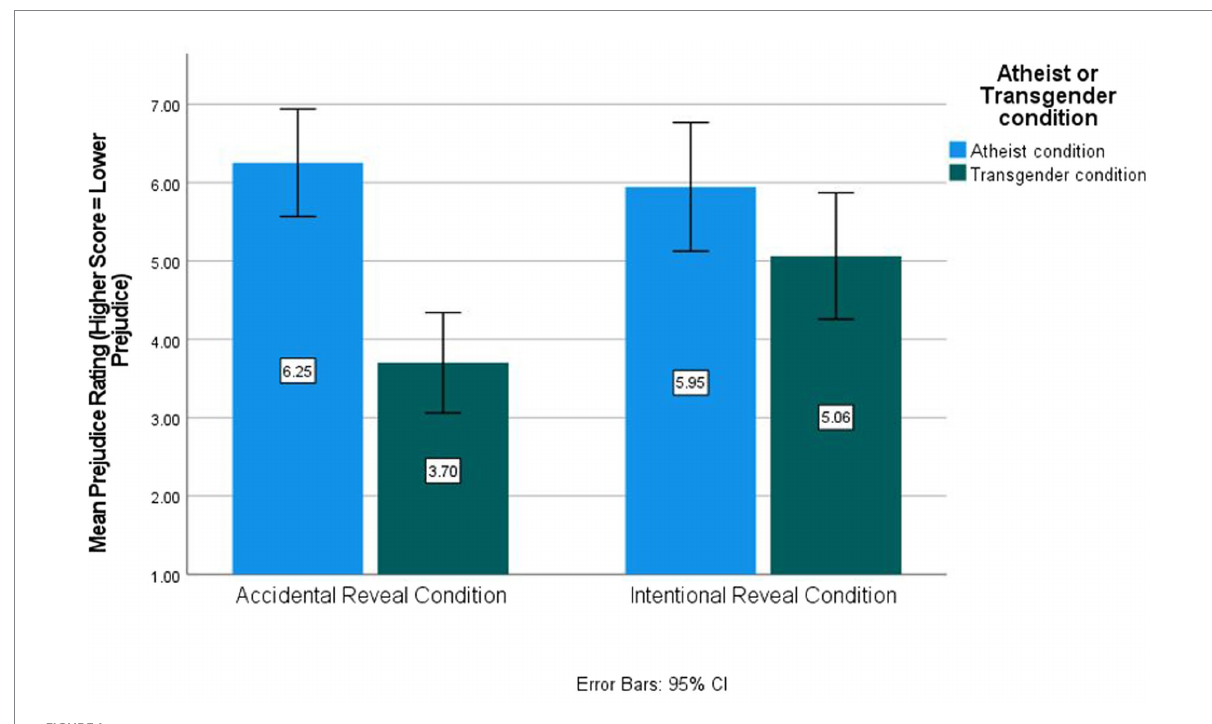
FIGURE 1 Target-specific attitudes by condition for Study 1 (lower score = higher